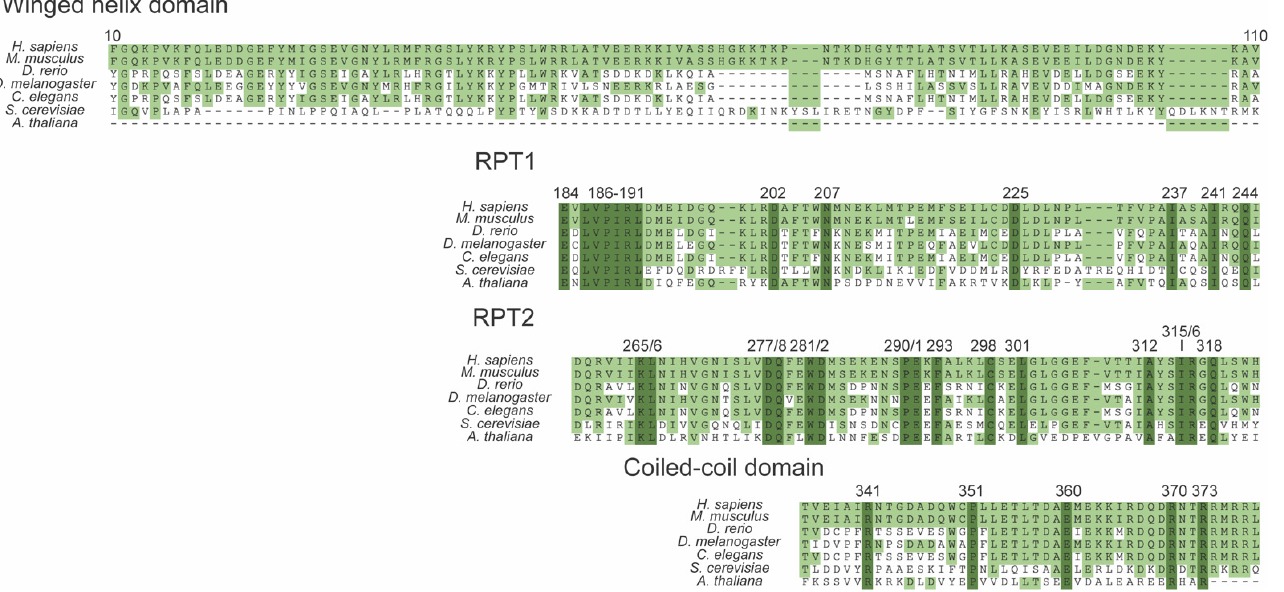
Figure 2 . Conservation of SMARCB1 across seven eukaryotic species: H. sapiens-NP_003064.2, M. musculus-BAB12427.1, D. rerio-NP_001007297.1, C. elegans-NP_001369845.1, S. cerevisiae- ONH79494.1, and A. thaliana-NP_001189918. Light green boxes represent amino acid residues that match the H. sapiens SMARCB1 sequence. Dark green residues represent amino acid residues that are conserved in all seven eukaryotic species used in this analysis.